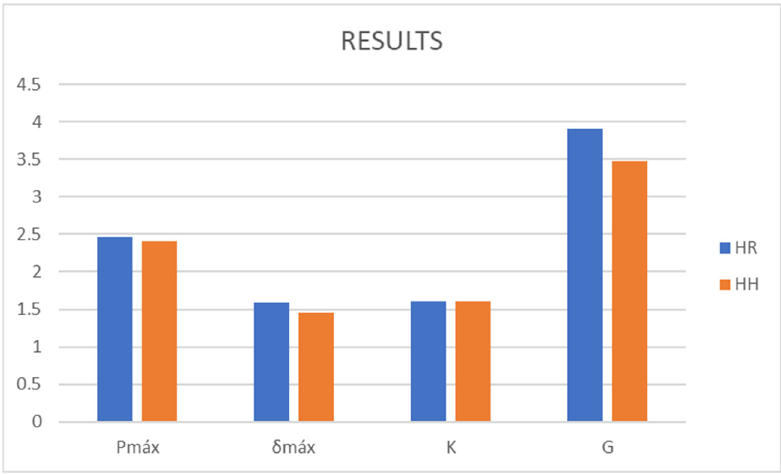
Figure 6. Increases in the average values of the properties of reinforced beams.